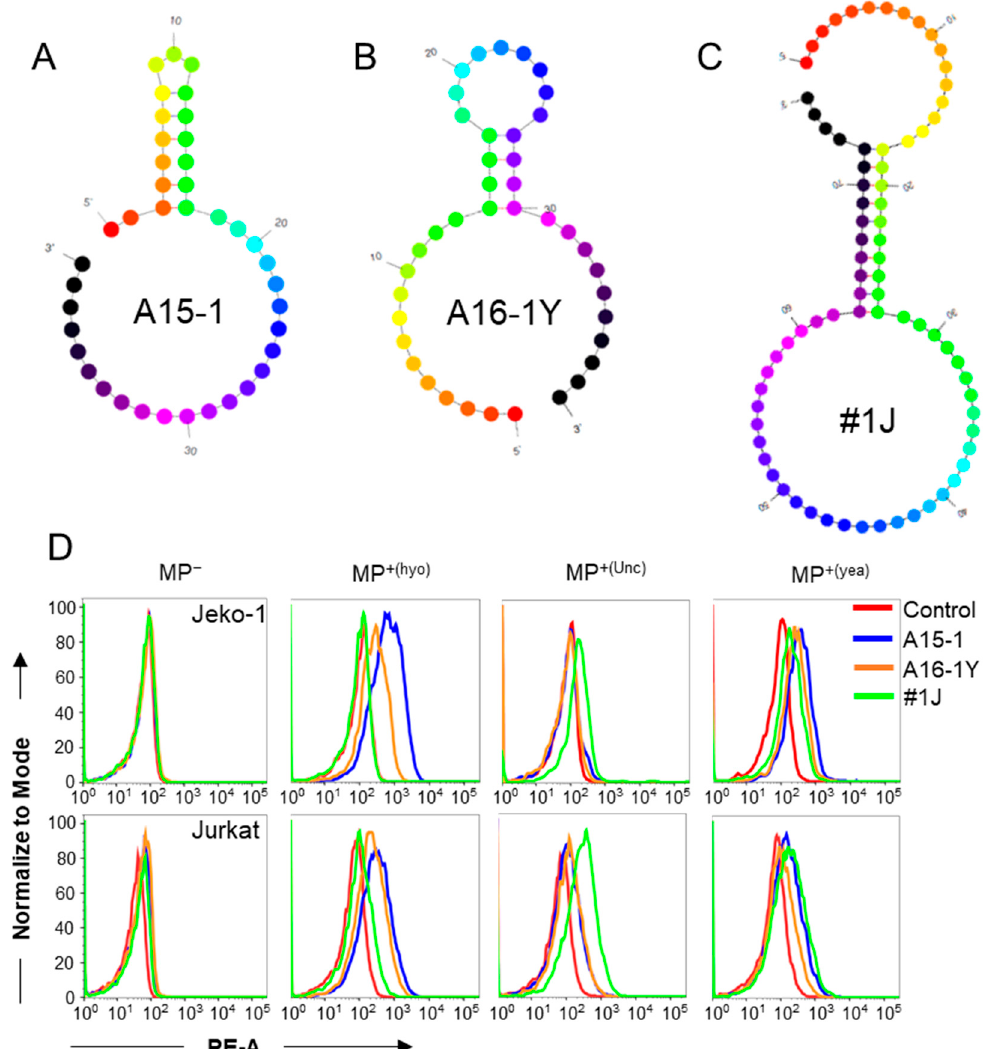
Figure 4. Screening of aptamers for targeting different species of mycoplasma ‐ infected cells. ( A – C ) The predicted secondary structures of A15 ‐ 1 ( A ), newly screened A16 ‐ 1Y ( B ), and #1J ( C ) aptamers; ( D ) A15 ‐ 1, A16 ‐ 1Y, and #1J binding tests on other species of mycoplasma ‐ infected Jeko ‐ 1 and Jurkat cells using flow cytometry. The control aptamer is L14 ‐ 2. MP − , mycoplasma negative; MP +(hyo) , M. hyorhinis positive; MP +(Unc) , unclassified mycoplasma negative; MP +(yea) , mixed mycoplasma positive. Data show the representative results from three independent experiments.